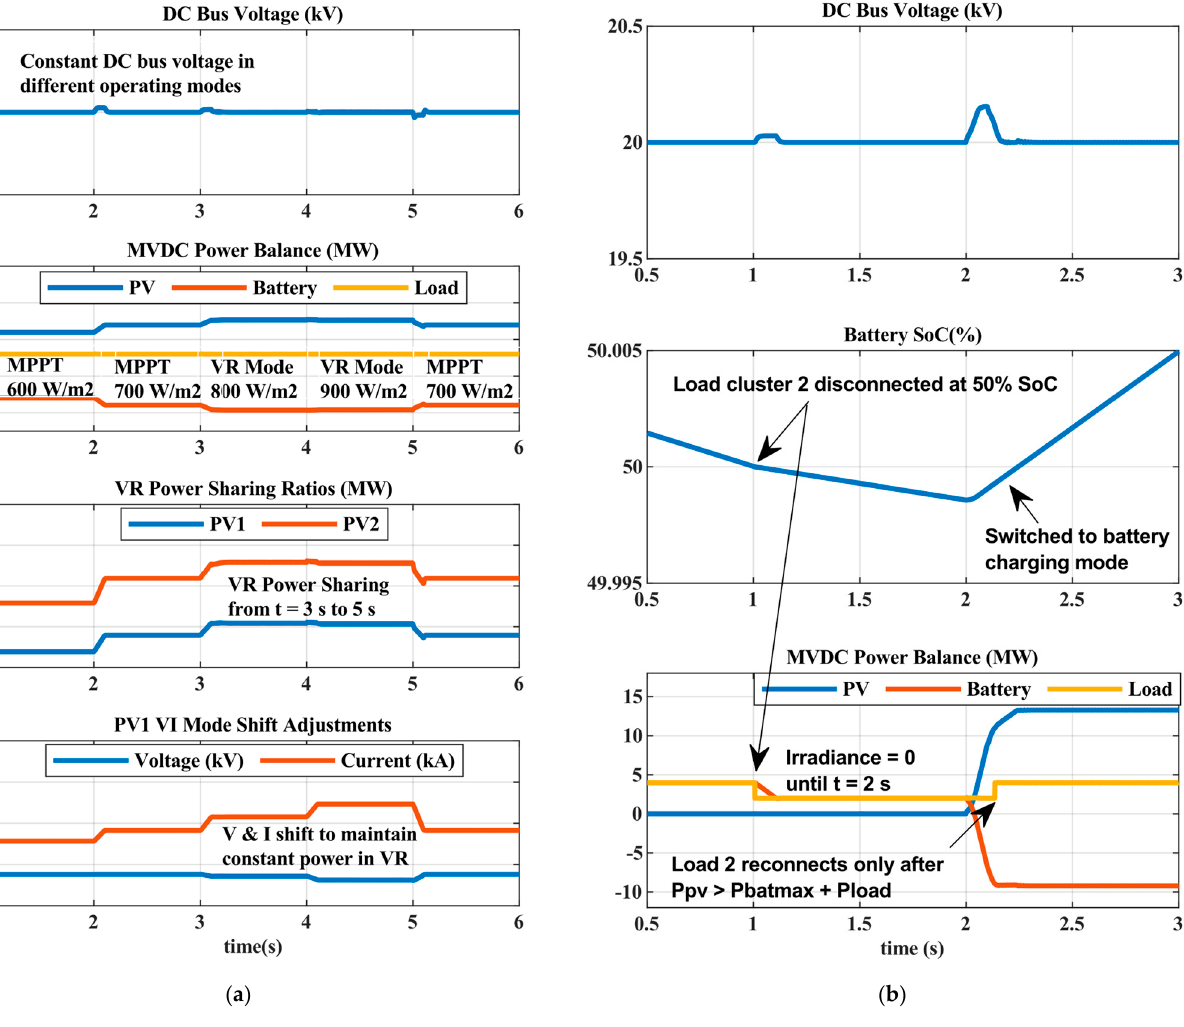
Figure 8. Simulation results for the isolated MVDC Distribution System (DC Side): ( a ) MPPT–VR–MPPT mode shift to maintain constant DC link voltage, ( b ) load shedding and restoration sequence illustration.